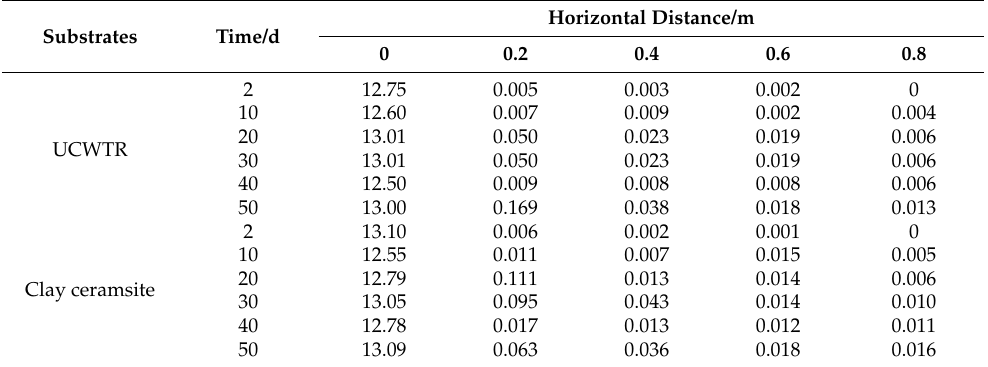
Table 3. Change in horizontal Pb concentration at 2 d, 10 d, 20 d, 30 d, 40 d, 50 d